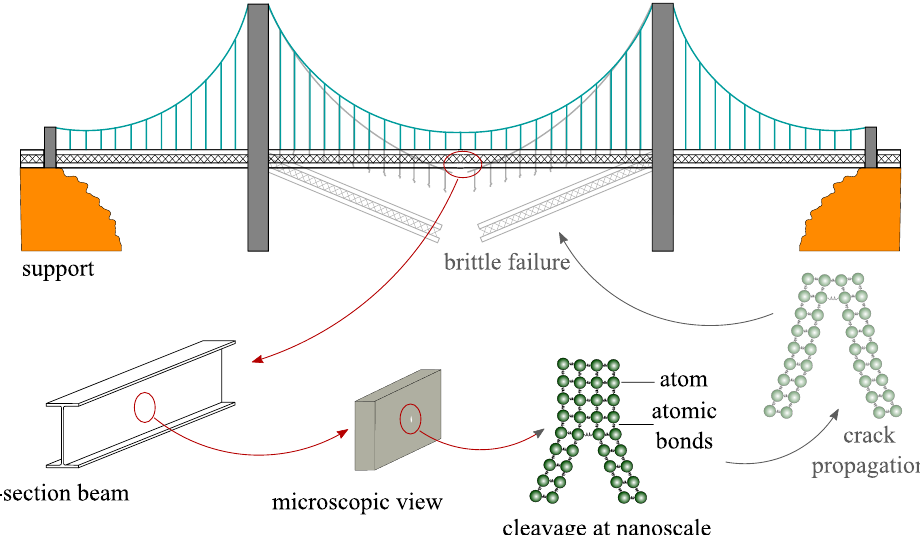
Figure 1. Schematic representation of a bridge and its possible collapse due to material fracture, which can be traced back to the collapse of atomic bonds on the nano